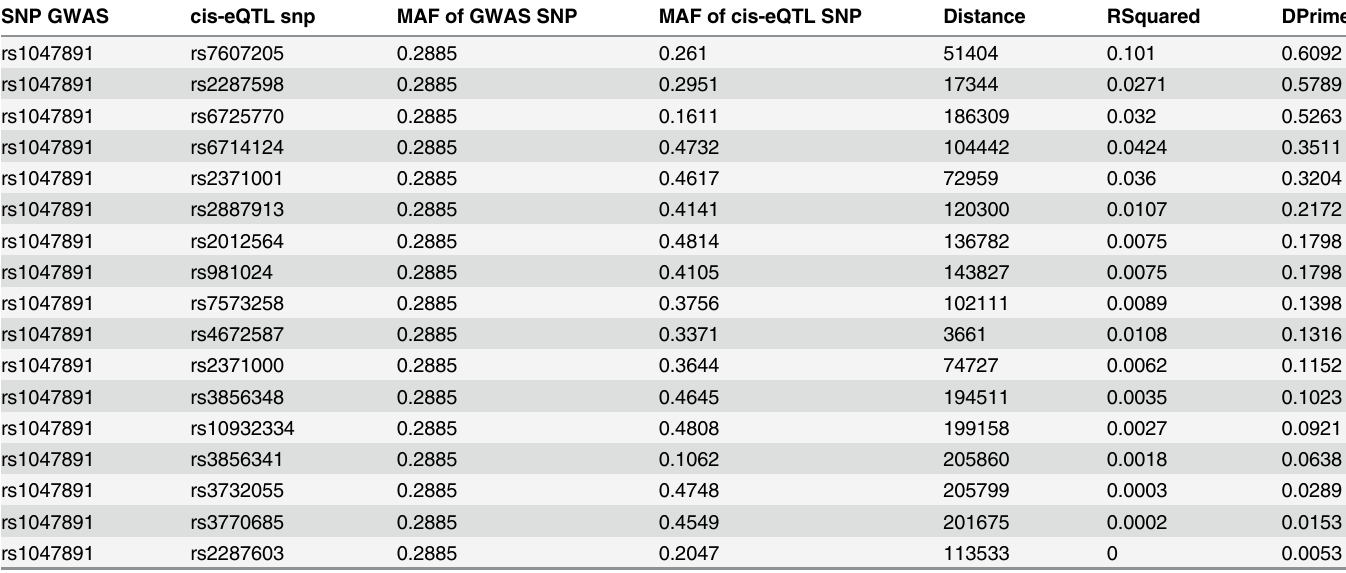
Table 1. Pair-wise linkage